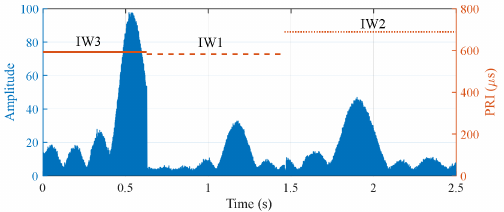
Figure 2. The Sentinel-1 signal received by a directional antenna fixed on the ground: three different PRIs and amplitude differences of these IW signals can be